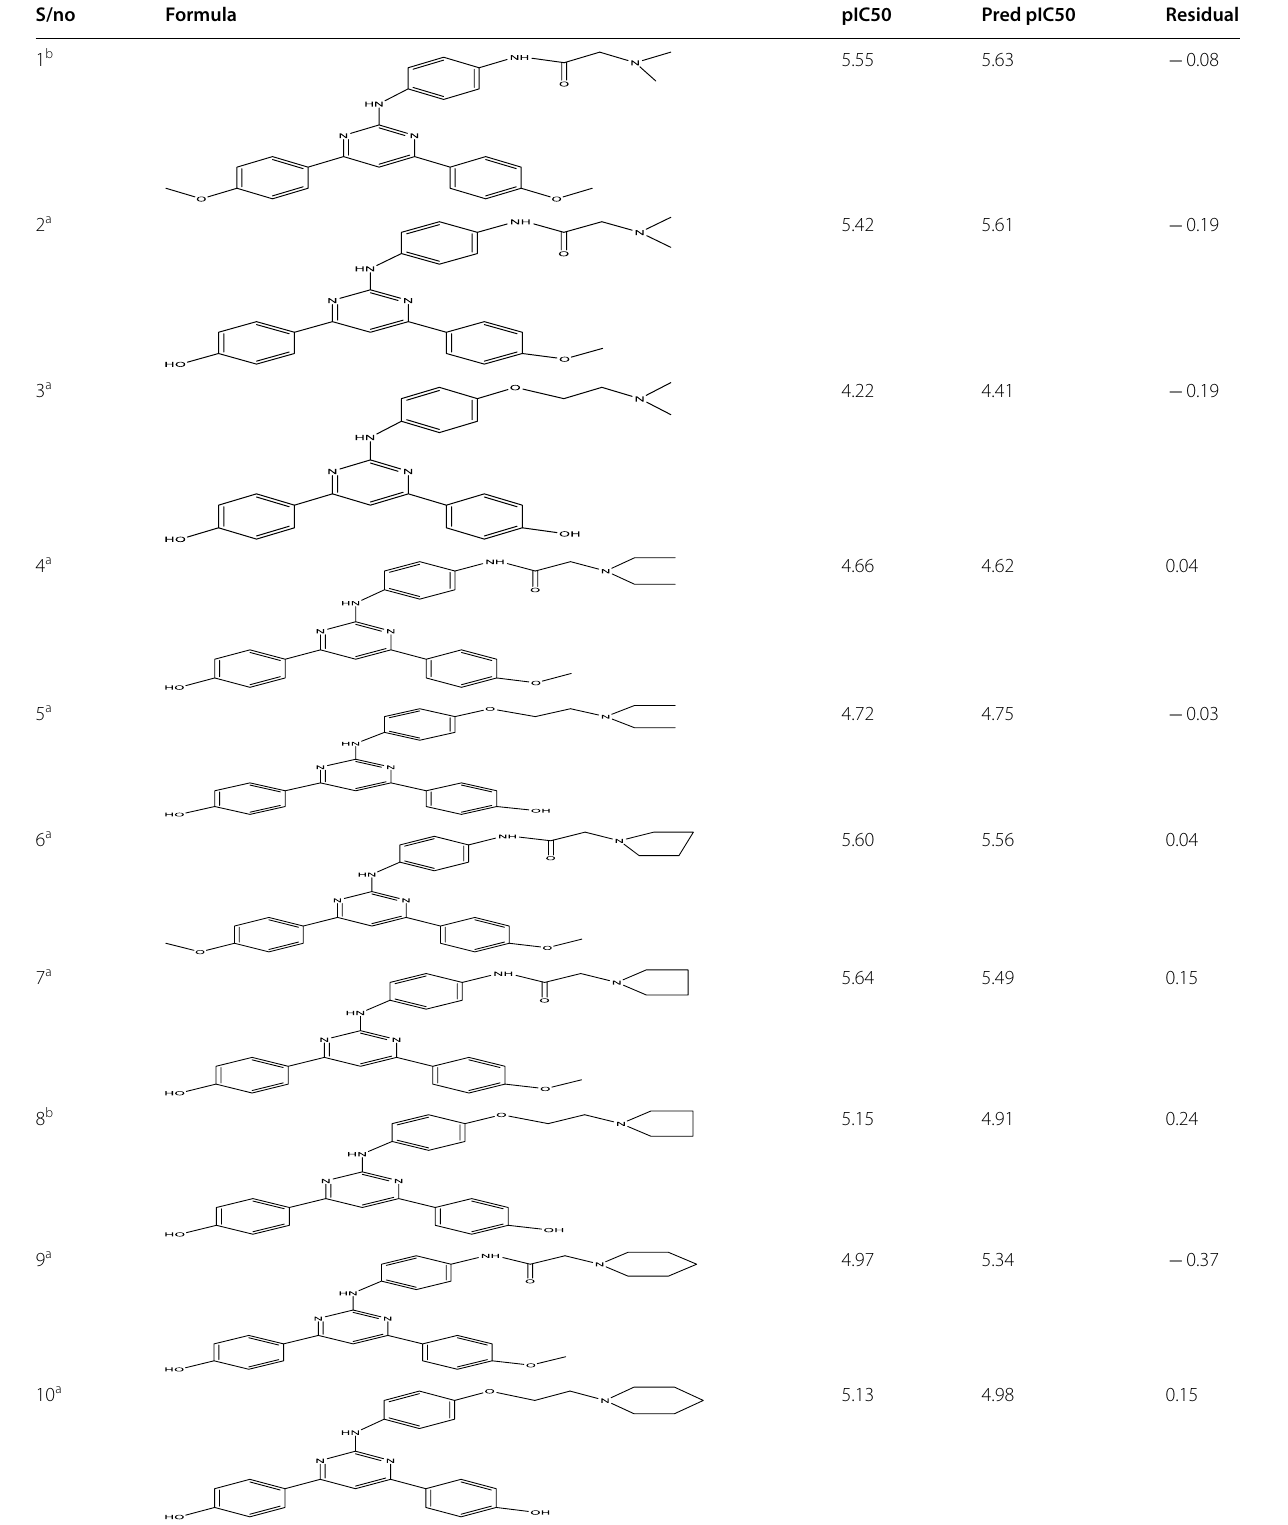
Table 1 Actual and computed pIC values of 4,6-diaryl-2-pyrimidinamine series against HUVEC cancer cell 50